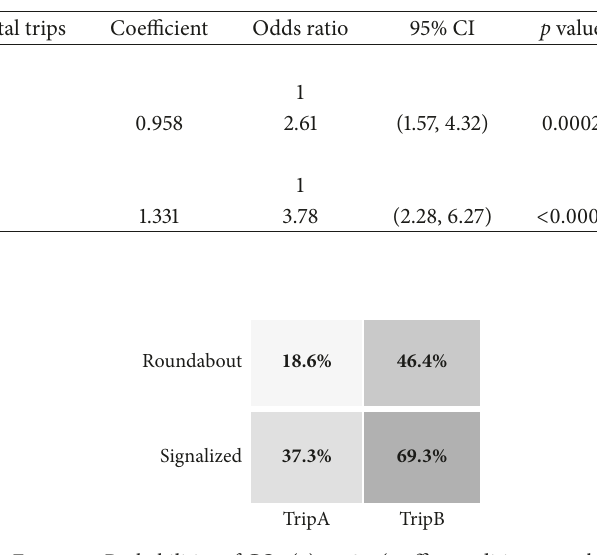
Figure 5: Probabilities of CO 2 (g) ≥ 58 g (traffic condition =